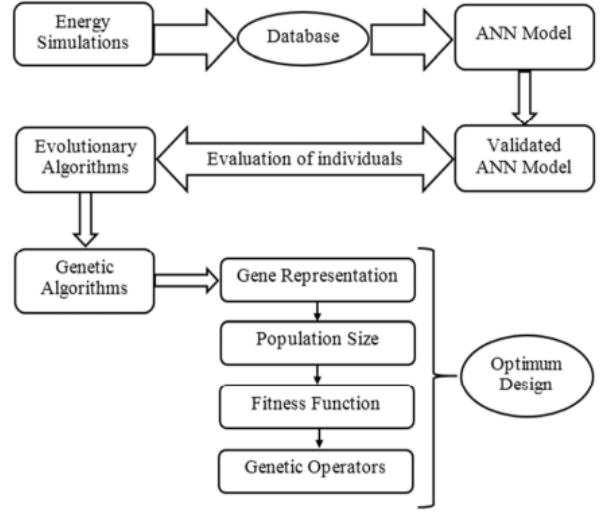
Figure 1. The building design optimization workflow.